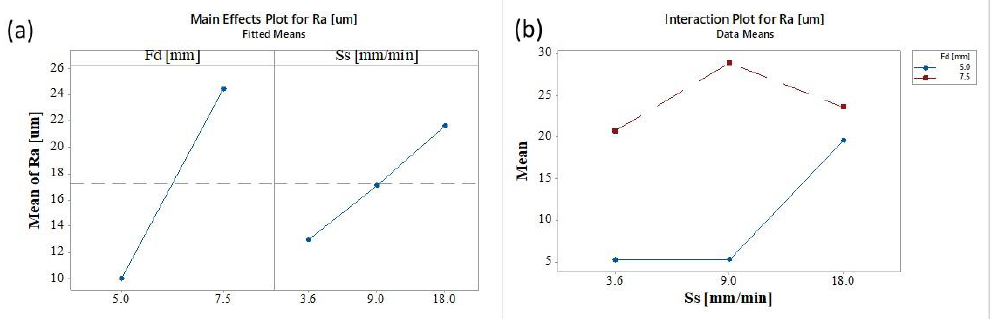
ff ect plot and ( b ) interaction plot for Ra. Figure 13. ( a ) Main effect plot and ( b ) interaction plot for Ra. Figure 13. ( a ) Main e